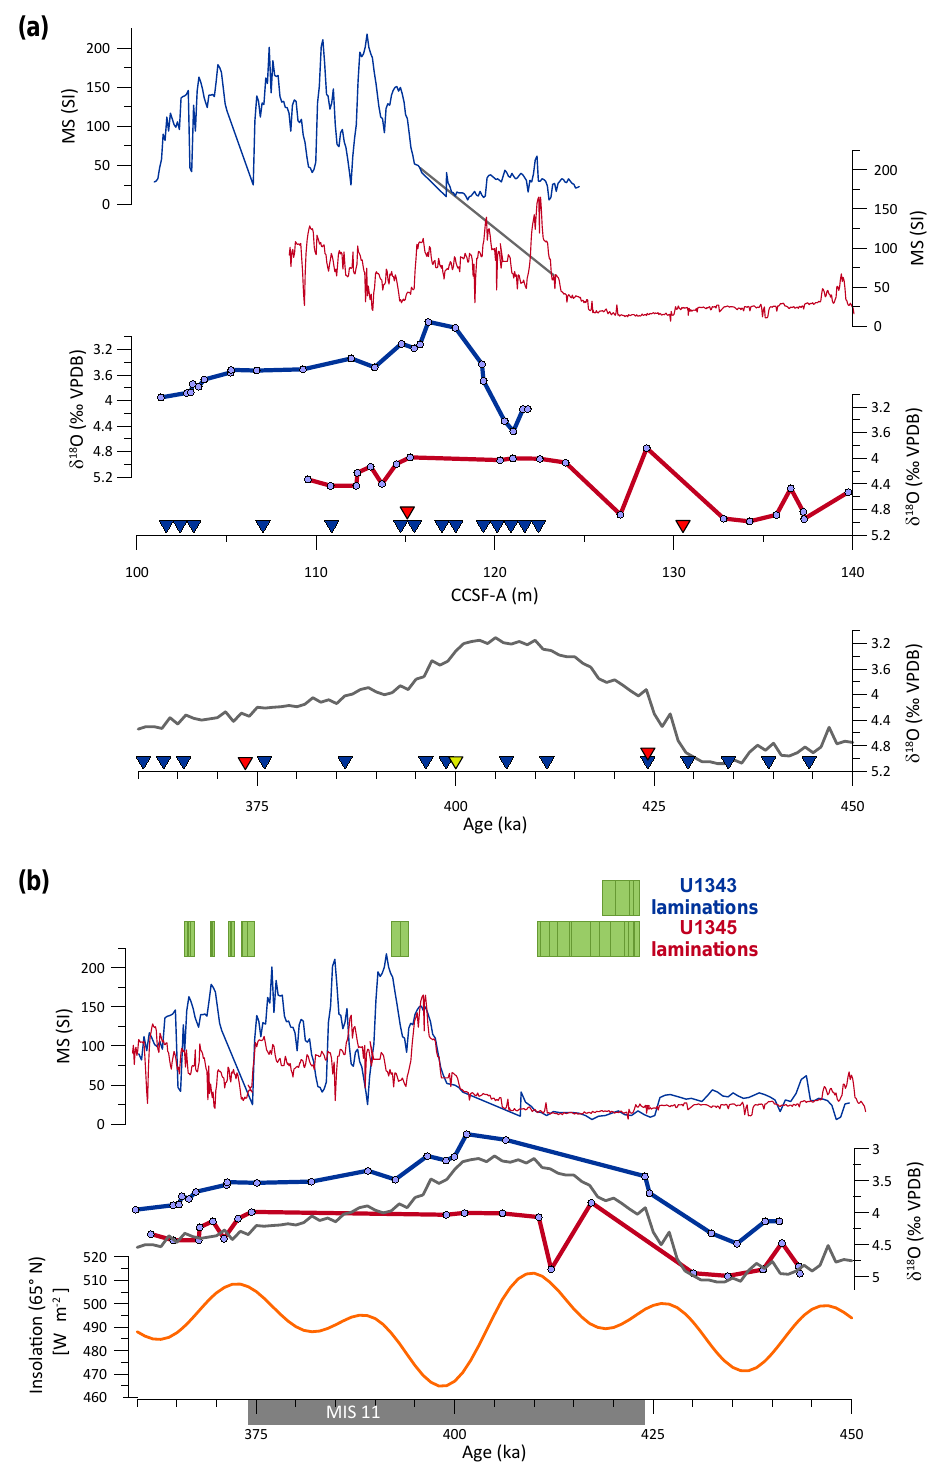
Figure 3. (a) Age model plotted by depth. Blue plots depict data from Site U1343, while red plots are from U1345. Magnetic susceptibility and benthic foraminiferal δ 18 O are plotted by depth for each site in the top half of the figure. The grey line joining the magnetic susceptibility plots indicates the tie point that was added in this study. Inverted triangles indicate locations of tie points (red: U1345; blue: U1343; grey: magnetic susceptibility) between Bering Sea δ 18 O (Cook et al., 2016; Asahi et al., 2016) and the global marine stack (Lisiecki and Raymo, 2005), which is plotted in grey. (b) Age model plotted by age. Magnetic susceptibility and δ 18 O are shown with the global marine δ 18 O stack (grey) and insolation at 65 ◦ N (orange). Green bars indicate laminated intervals in U1343 and U1345.